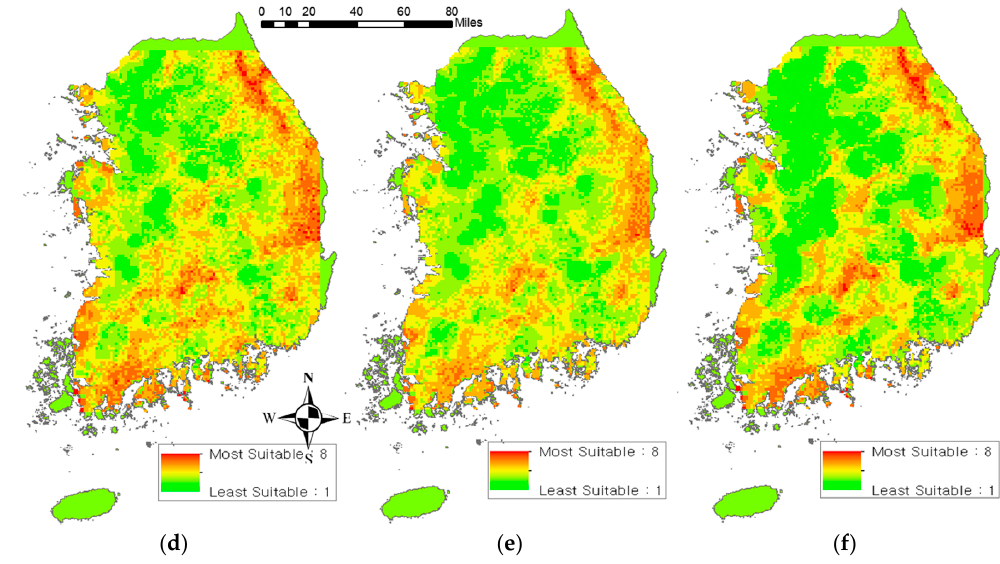
Figure 6. Wind farm suitability maps ( a ) Scenario 1 ( b ) Scenario 2 ( c ) Scenario 3 ( d ) Scenario 4 ( e ) Scenario 5 ( f ) Scenario 6.